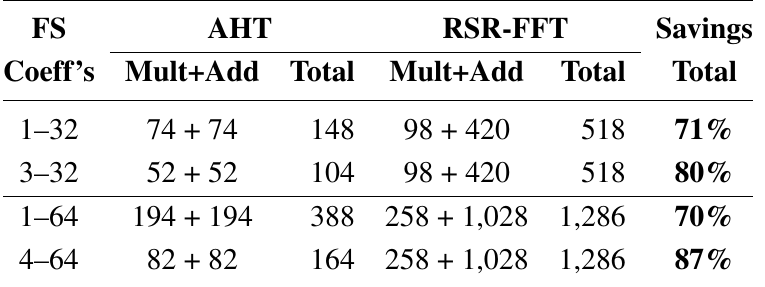
Figure 4. Structure of matrices U